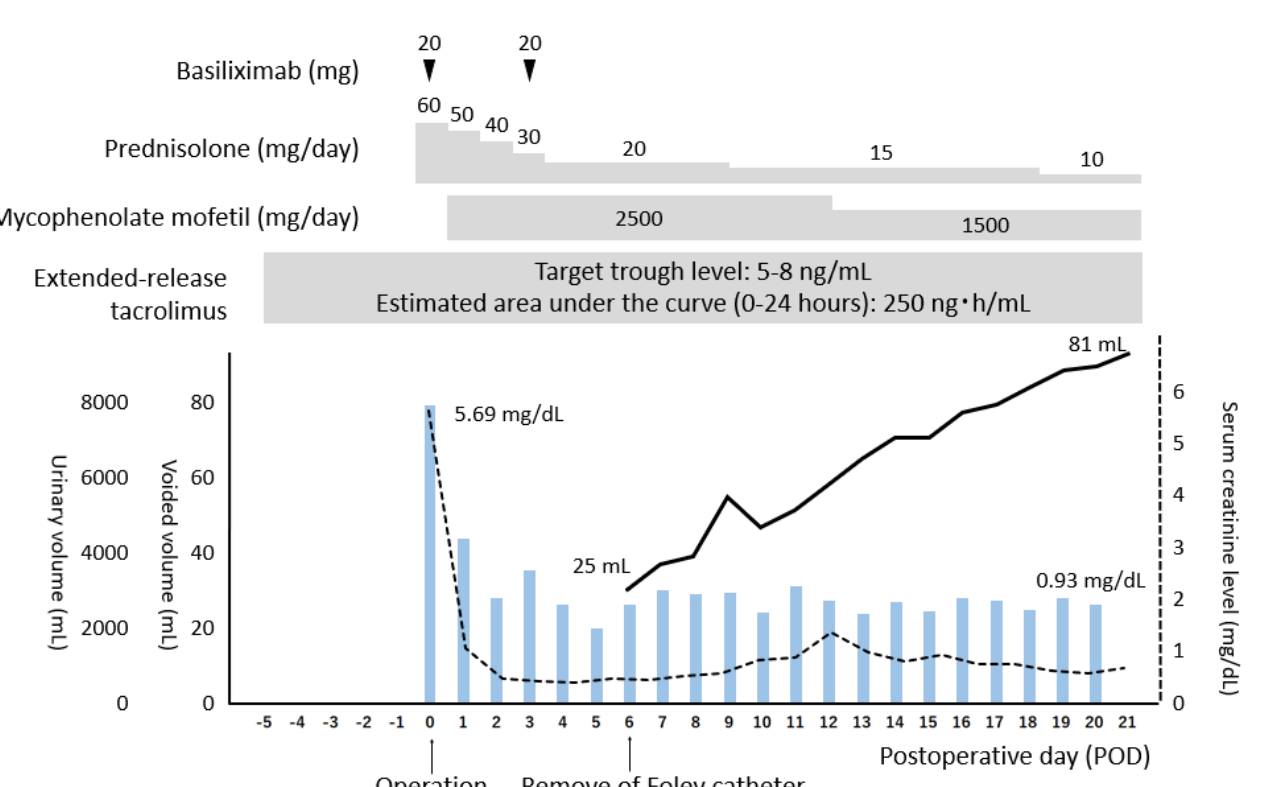
Figure 2. The postoperative clinical course, which was uneventful. Blue bar, black solid line and dotted line represents urinary volume, voided volume and serum creatinine level, respectively.